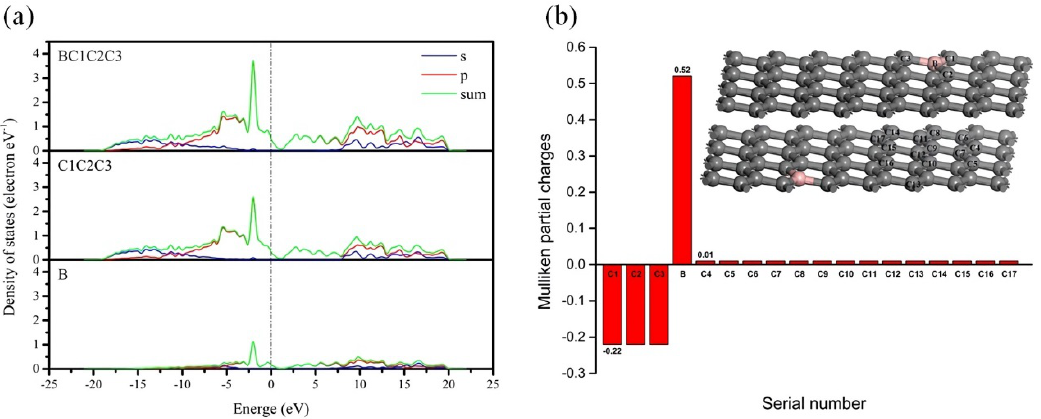
Figure 5. ( a ) Partial density of states of B, C1C2C3 and BC1C2C3. ( b ) Mulliken partial charges of some atoms in model ( b ). Inset: the serial numbers of the atoms in the layers of model ( b ). Carbon: dark grey; boron: pink.